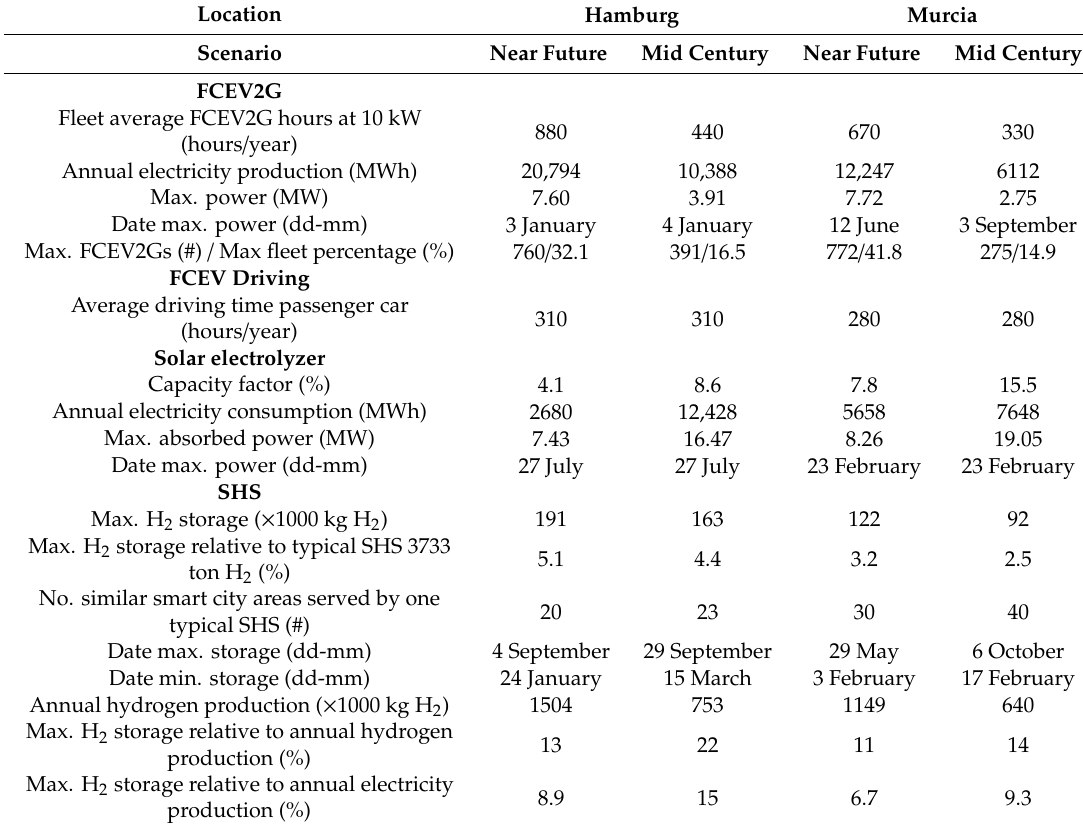
Table 3. Key energy balance parameters for FCEVs through vehicle-to-grid (FCEV2G), solar electrolyzer, and SHS usage for Hamburg and Murcia in the Near Future and Mid Century